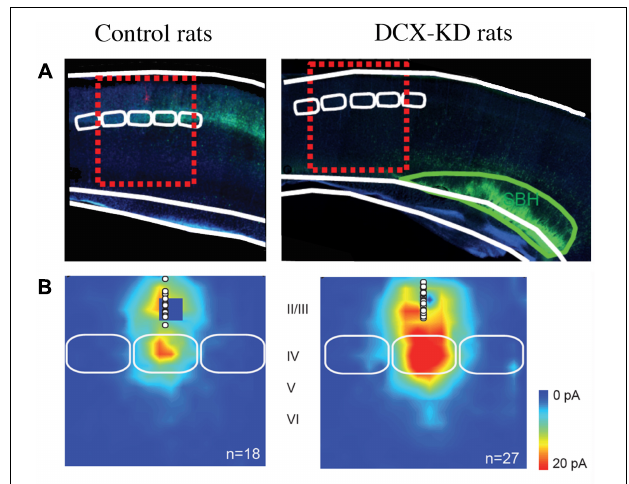
FIGURE 1 | Collateral Alterations of Functional Cortical Circuits in a Rat Model of Subcortical Band Heterotopia. (A) Representative examples of across-barrel brain slices from control (Mismatch) and Dcx-KD rats. Fluorescence microphotographs of electroporated cells are superimposed on schematized views of barrels (in white) and SBH (in green). Red dashed line rectangles illustrate the cortical columns evaluated in the study. (B) Excitatory synaptic input maps for L2/3 neurons in mismatch and Dcx-KD rats. Colors indicate the mean amplitude of excitatory synaptic responses in a 100-ms time window. White circles show soma positions of recorded L2/3 neurons. Solid white lines delineate barrels. Note that in DCX-KD rats the strength of excitatory inputs to L2/3 neurons are dramatically increased (for more details see Plantier et al.,